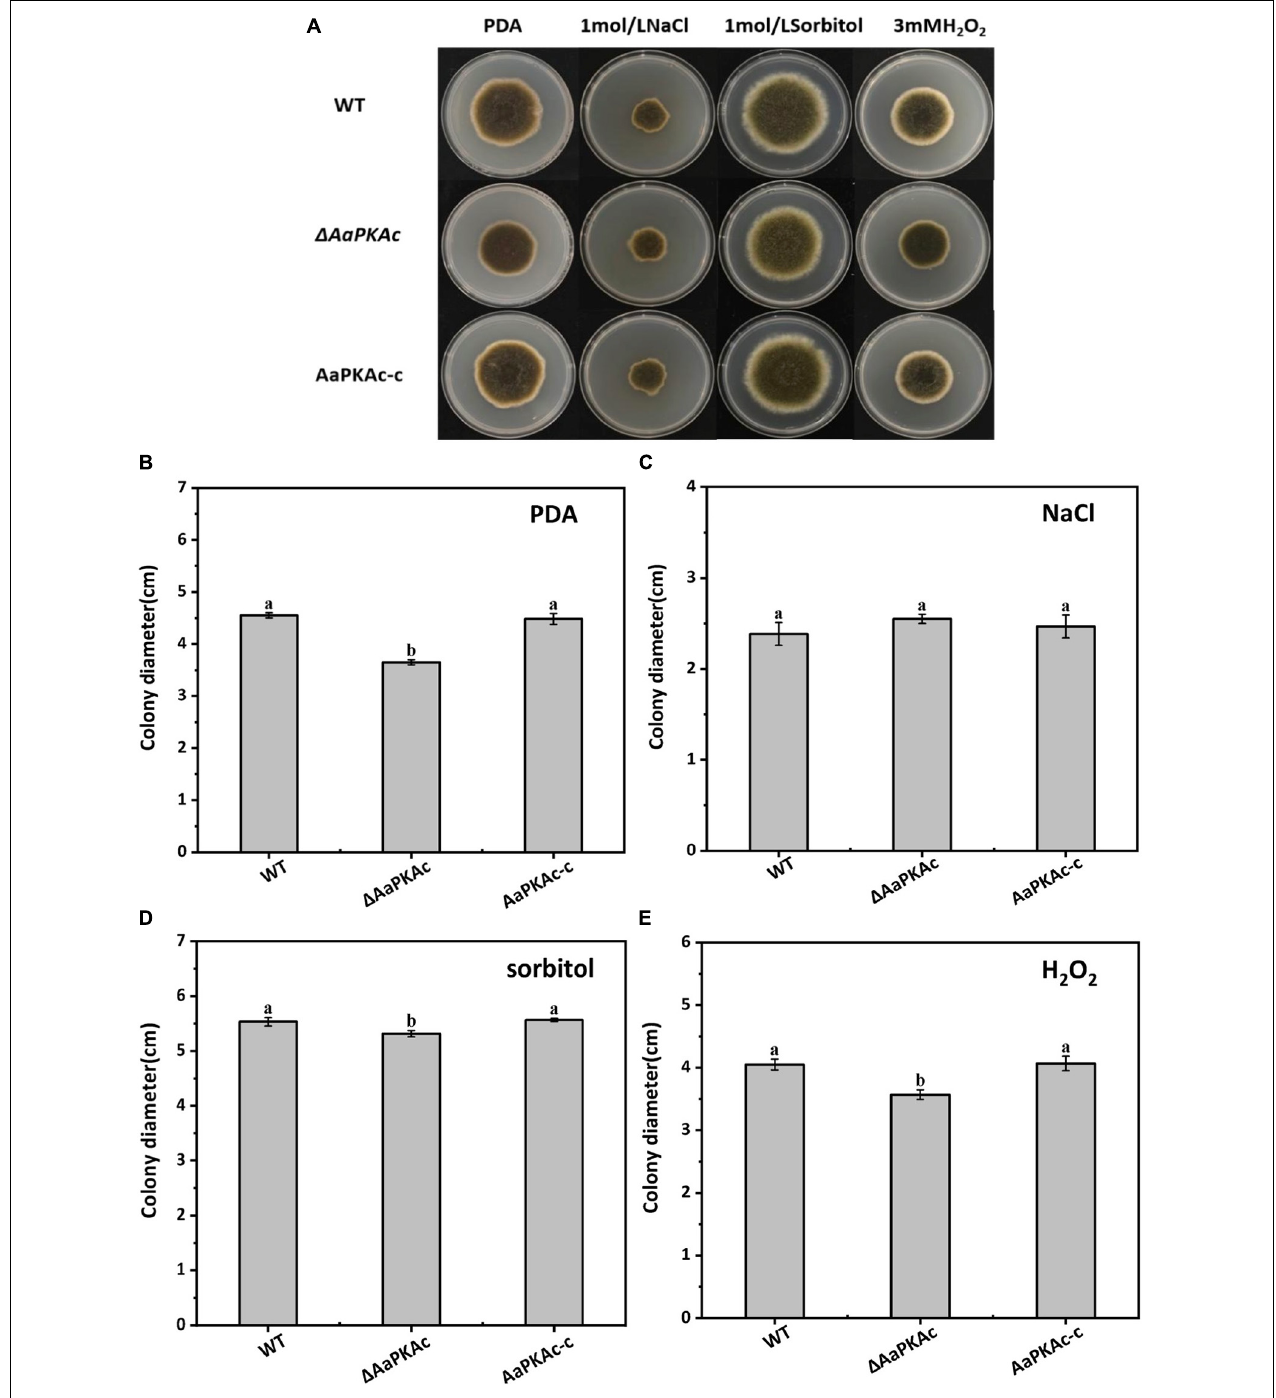
FIGURE 5 | Effect of AaPKAc on osmotic stress and oxidative stress tolerance. Images of the wild-type strain (WT), (cid:49) AaPKAc mutant, and AaPKAc genetic complementation strain (AaPKAc-c) were taken after 5 days of incubation on PDA supplemented with 1 mol L − 1 NaCl, 1 mol − 1 sorbitol, or 3 mM H 2 O 2 (A) . Colony diameters of A. alternata were determined after 5 d of incubation on PDA (B) supplemented with 1 mol L − 1 NaCl (C) , 1 mol − 1 sorbitol (D) , or 3 mM H 2 O 2 (E) .